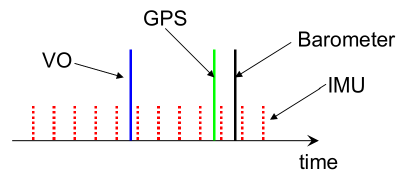
Figure 8. A ring buffer is utilized to keep 2 s of incoming sensor information. Due to the image transmission and Visual Odometry (VO) calculation delay, the newly-arriving VO measurements do not have the newest time stamp. The VO will update the EKF state on the VO time, and the subsequent IMU integral is re-integrated to predict the current